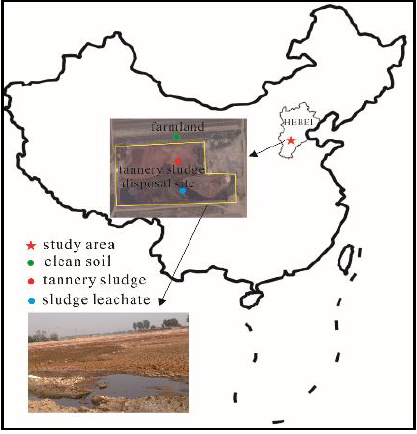
Figure 1. Location of the contaminated site and sites of soil sampling.